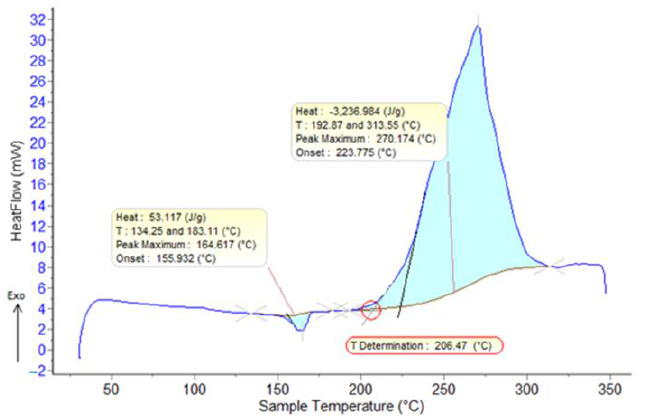
Figure 2. DSC curves (air, 10 °C/min) for PP.